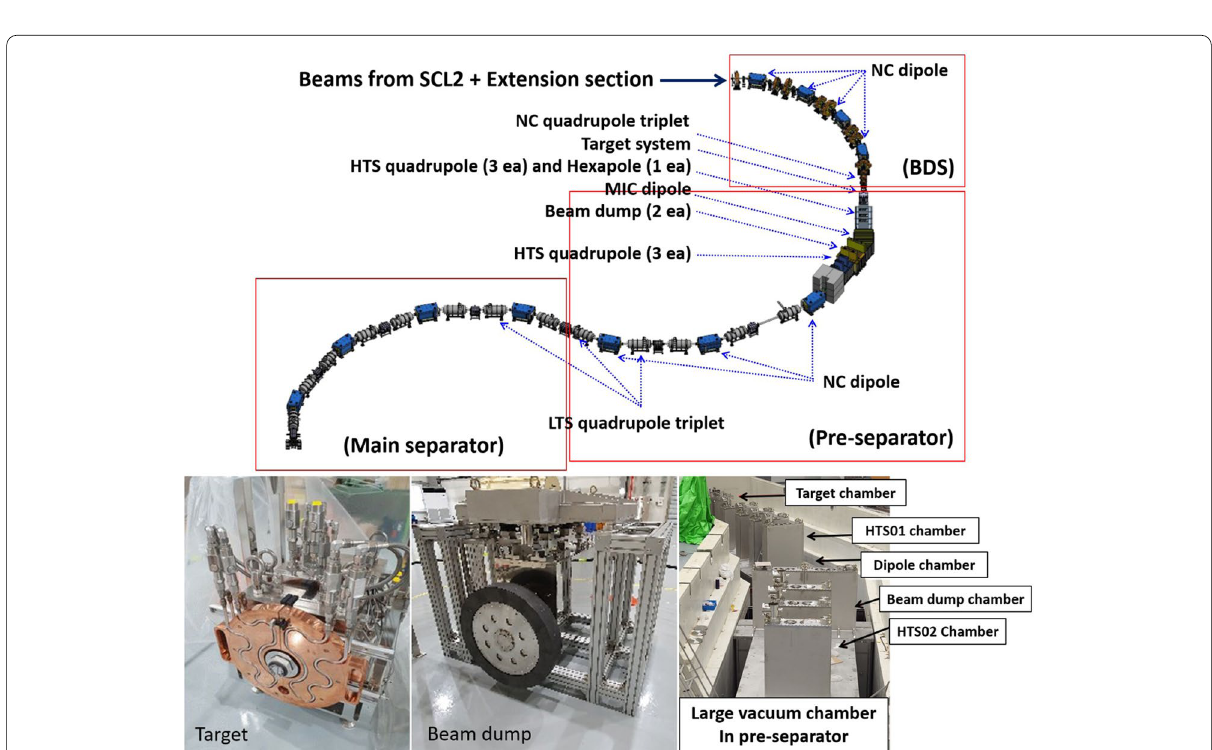
Fig. 10 Schematic of the overall IF system shown in the top panel. The bottom panels show the images of the IF target, beam dump, and large vacuum chamber in the